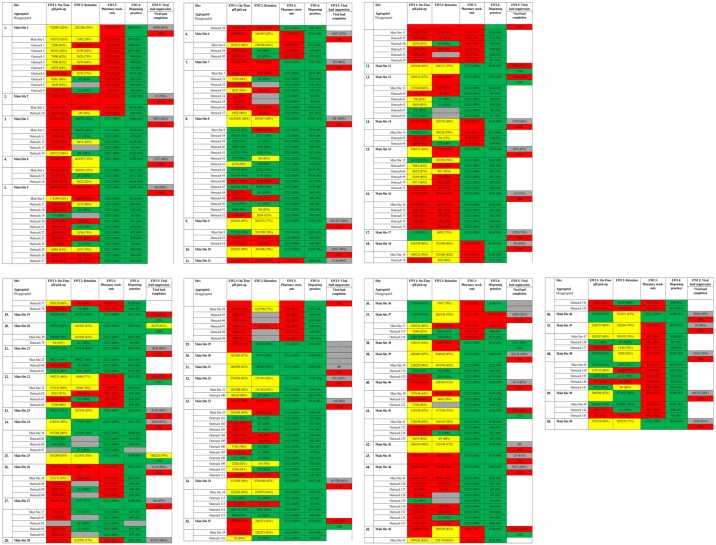
Adult Site-specific EWI Results.EWI—Early Warning Indicators Green indicates sites that achieved excellent performance, desired target level. Yellow indicates sites that achieved fair performance, progressing towards desired target level. Red indicates poor performance, below desired target. Gray indicates that data was not available from that site.